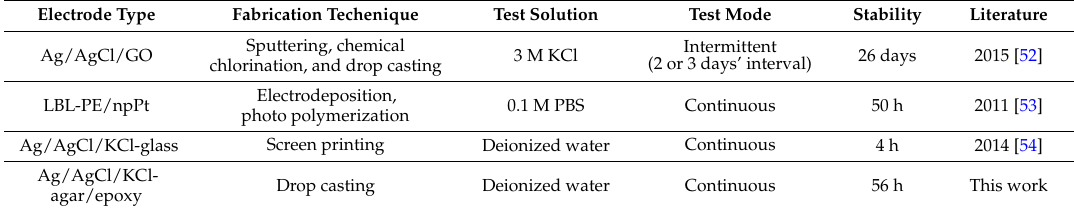
Table 1. Comparison of the performance of some solid-state reference electrodes for pH sensing.